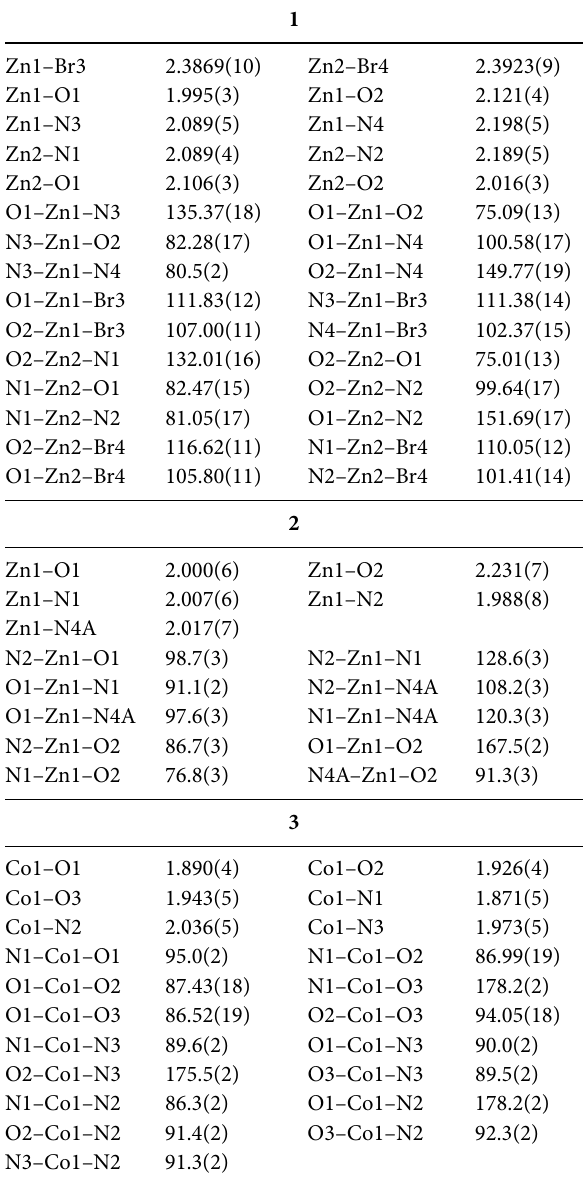
Table 2. Selected bond distances (Å) and angles (º) for the complexes